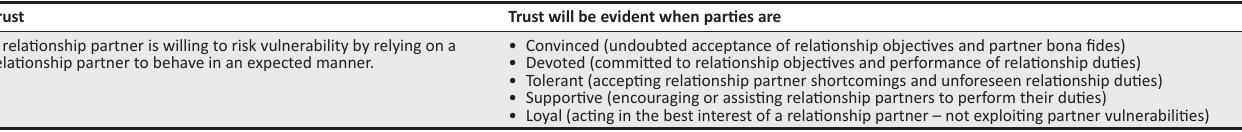
TABLE 1: Criteria for trust in labour relationships.